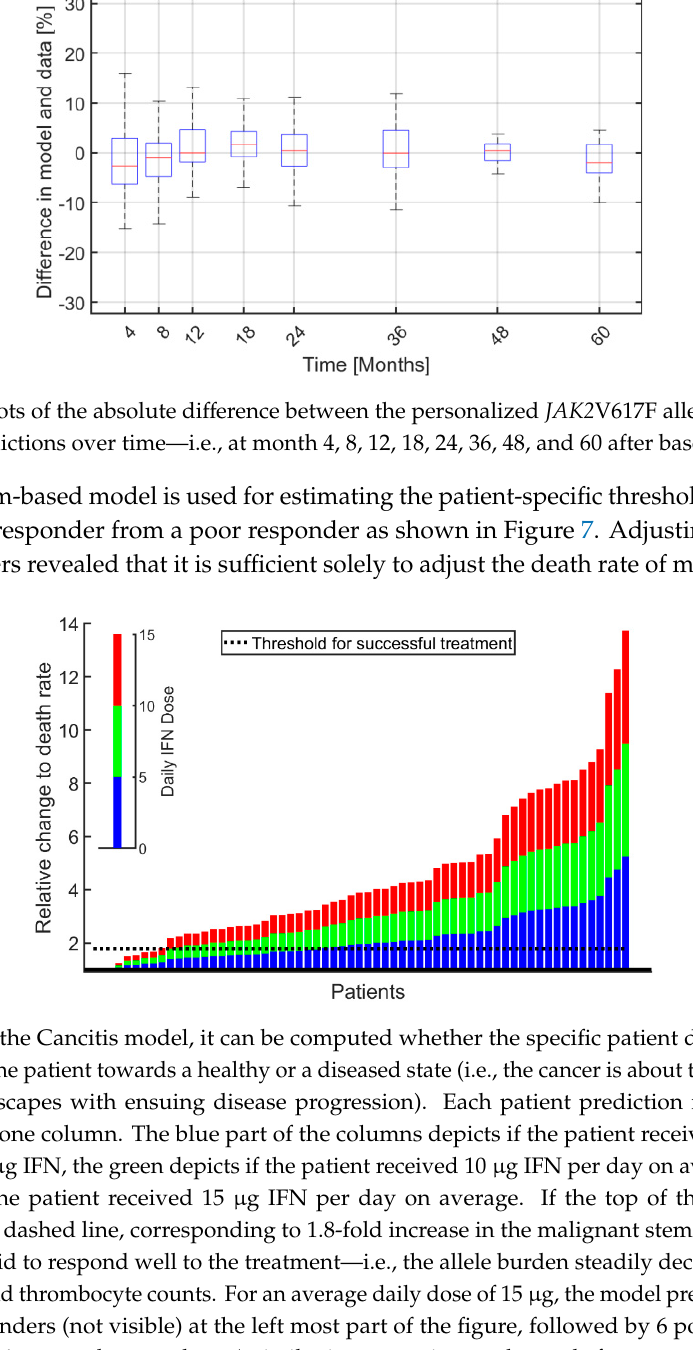
7 of 15 The full black curve shows data and the grey dashed curve shows model prediction using all data points for calibration. The dotted blue curve shows the model prediction, where for each step only the preceding data points were used. The dashed purple curve shows the predictions of the first three data points using these for calibration. Figure 5. The “confusion matrix” of model trajectories showing whether the Cancitis model correctly classifies the patient as having a partial molecular response (left). The true positives increase as more